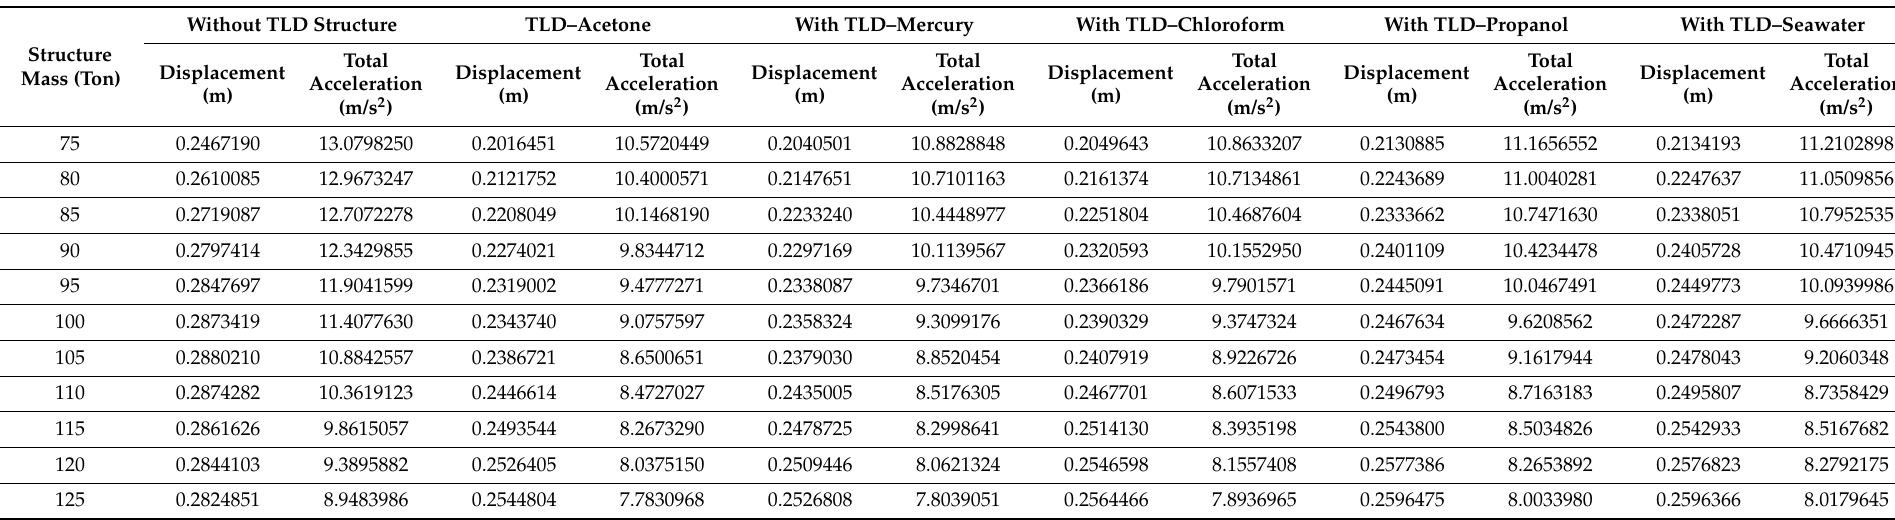
Table 6. The performance of the optimum TLD for the uncertainty of the mass of the single-story